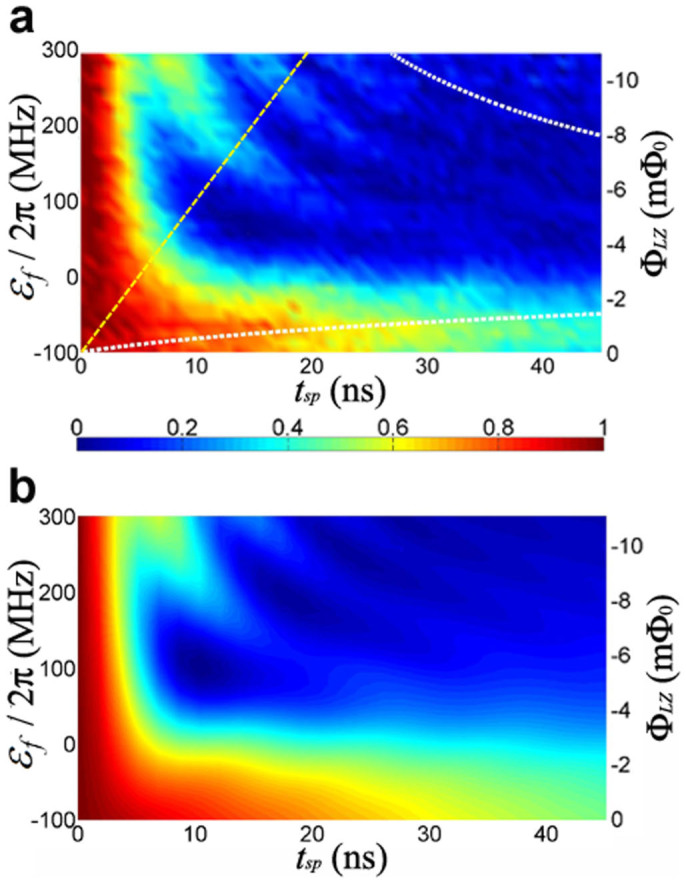
Coherent LZO.(a) Experimentally measured P↓ vs. εf and tsp. (b) Numerically calculated P↓ vs. εf and tsp with all input parameters obtained from the experiment. The white dashed lines correspond to the value of modified adiabaticity parameter α′ = 10. Notice that in the region below (above) the lower (upper) white dashed line, one has α′ ≫ 1 thus the system evolves adiabatically and no oscillation in P↓ is expected as confirmed experimentally. The LZ speed v equals the slope of any straight lines originated from the lower-left corner of the tsp-εf plane. For example, the yellow dashed line in (a) has v = 400/19.5 ≈ 20.5 MHz/ns. For the sake of clarity, the temporal evolution of the system along the yellow dashed line (constant v) is presented separately in Fig. 4(b).